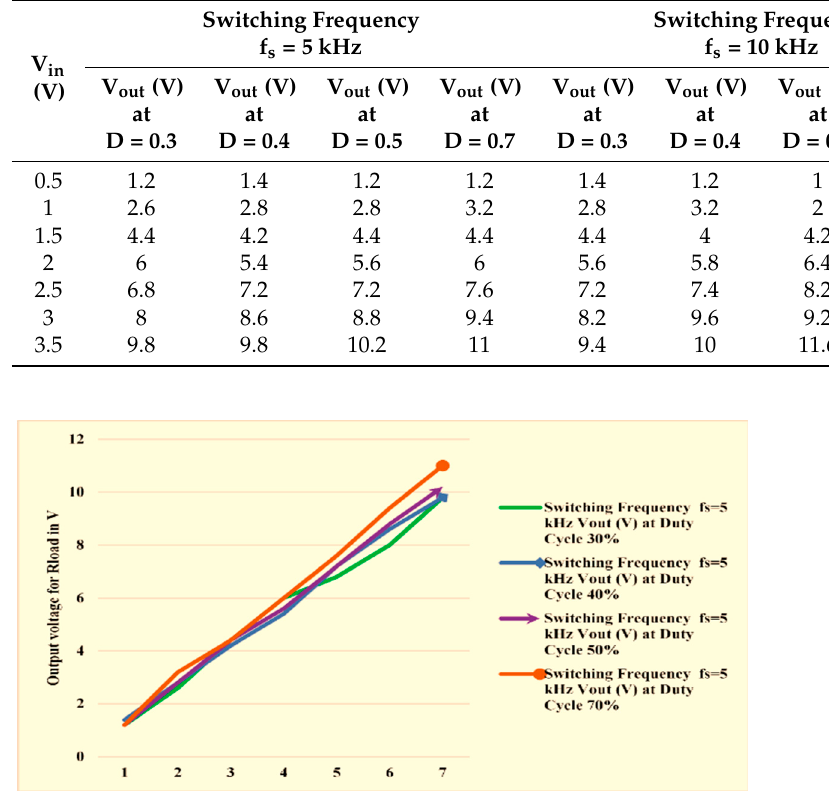
Figure 11. Output voltage comparison at different duty cycles and f s = 5 kHz.